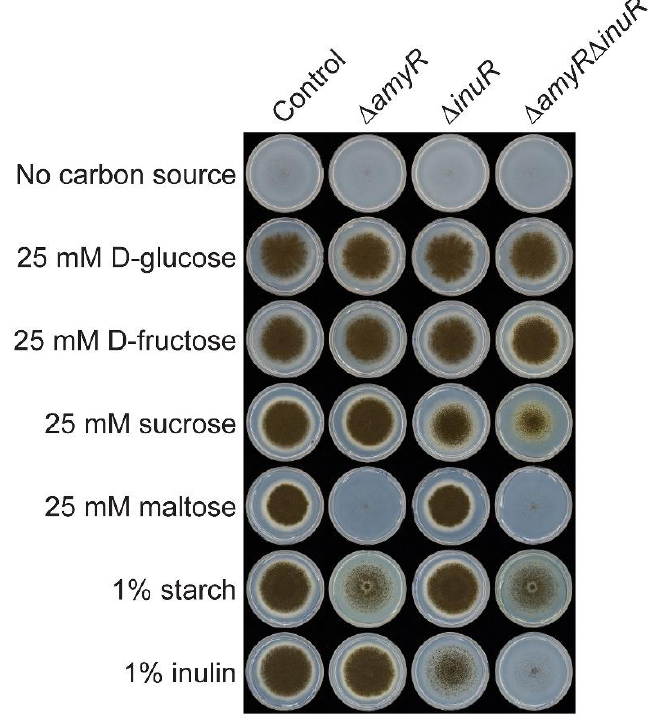
Figure 2. Growth profile of A. niger control, ∆ amyR , ∆ inuR and ∆ amyR ∆ inuR strains grown on starch, inulin and other starch/inulin-related carbon sources after 8 days of incubation at 30 °C.